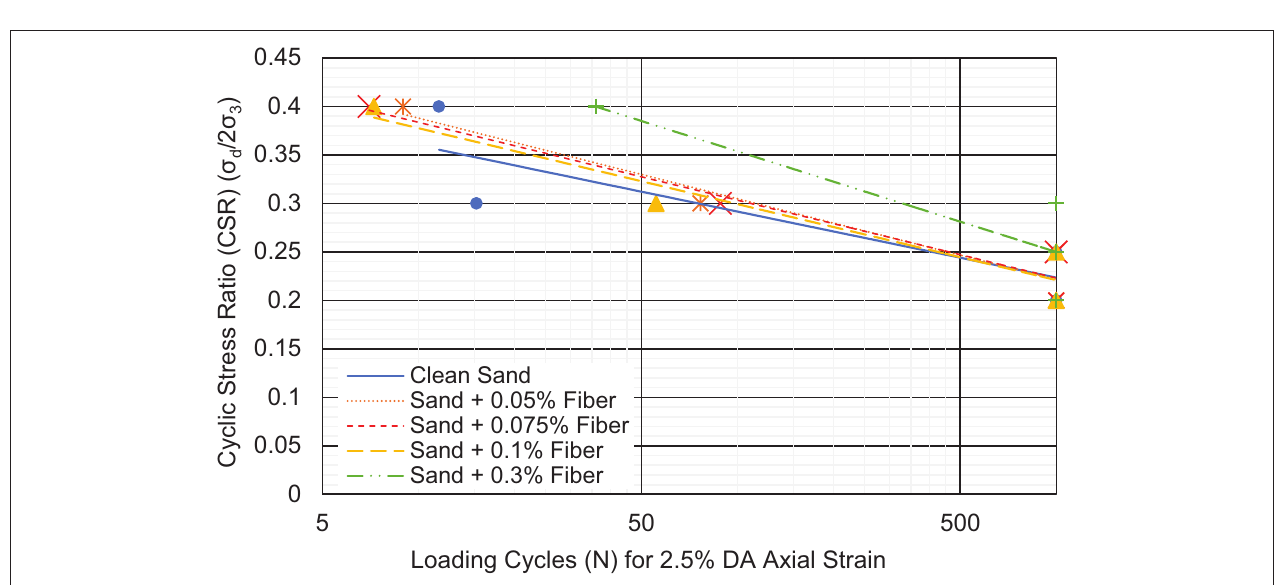
FIGURE 2 | Liquefaction resistance of sand containing various percentages of fibers at 34.48 kPa effective confining pressure in terms of 2.5% DA.